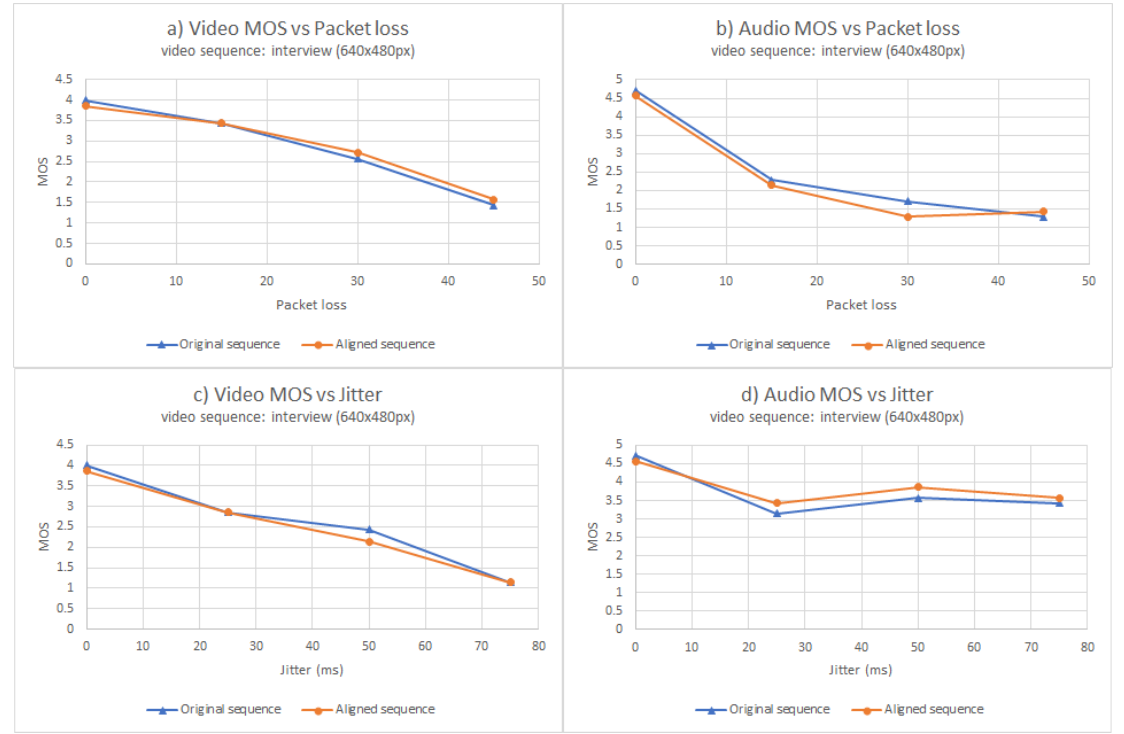
Figure 7. Comparison of the subjective results in the pilot for the interview sequence. ( a ) Video quality using different scenarios of packet loss. ( b ) Audio quality using different scenarios of packet loss.